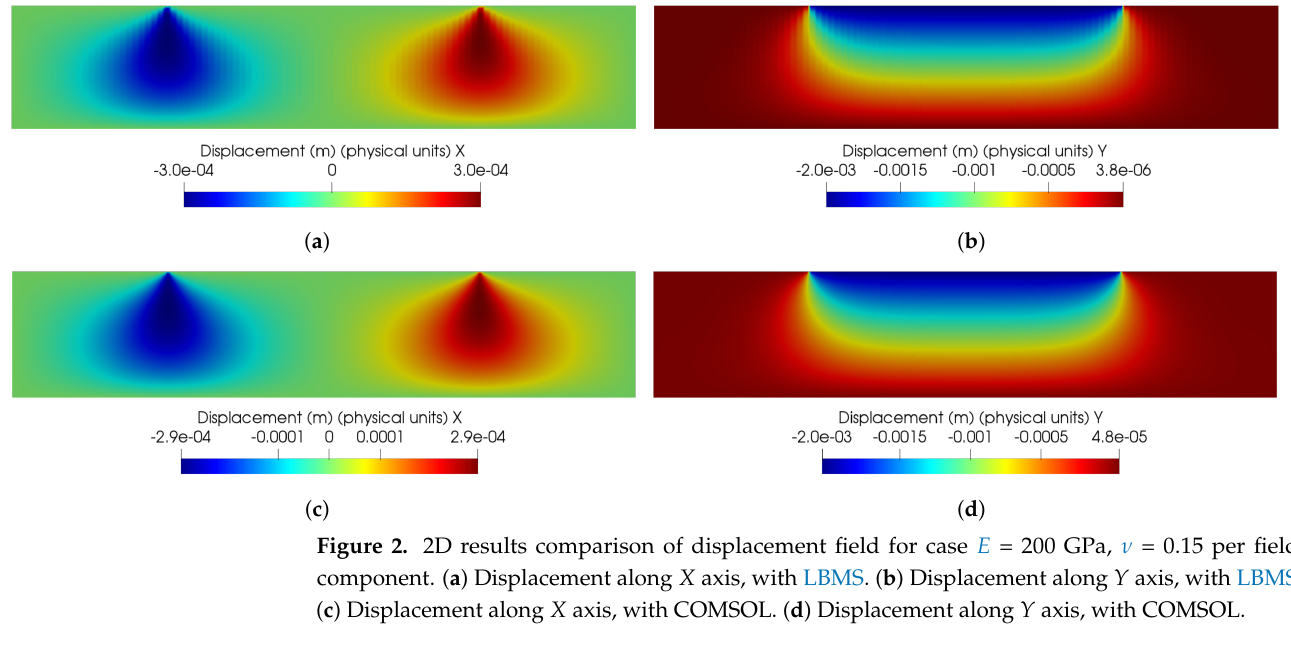
Figure 2. 2D results comparison of displacement field for case E = 200 GPa, ν = 0.15 per field component. ( a ) Displacement along X axis, with LBMS. ( b ) Displacement along Y axis, with LBMS. ( c ) Displacement along X axis, with COMSOL. ( d ) Displacement along Y axis, with